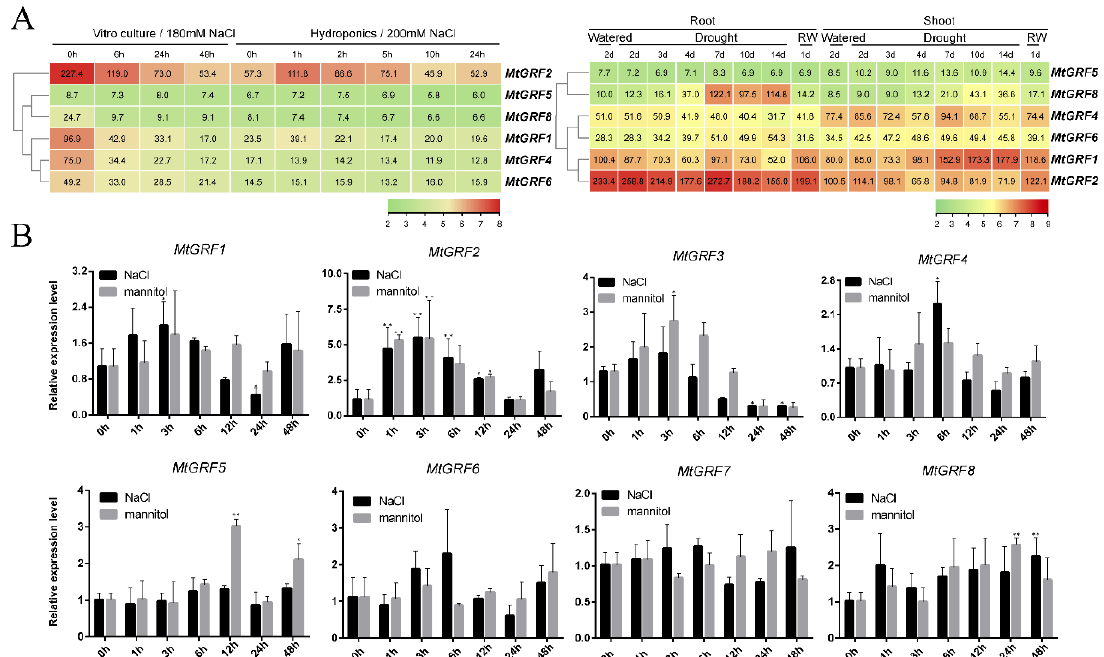
Figure 7. Expression profiles of MtGRF genes under NaCl and mannitol treatment. ( A ) Left, MtGRF genes expression level under drought treatment in roots and in shoots at different treatment times. Right, MtGRF genes expression level under vitro culture and hydroponics culture at different treatment times. ( B ) qPCR analysis on the expression of MtGRF genes treated with 300 mM NaCl and 15% mannitol at 0 h, 1 h, 3 h, 6 h, 12 h, 24 h, and 48 h. Data are the average of three independent biological samples ± SE, and vertical bars indicate standard deviation. ** indicates p < 0.01, and * for p < 0.05.